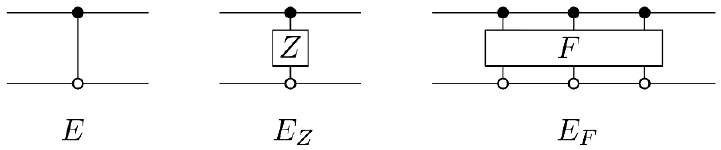
Figure 2 . The transfer operator E , as well as E Z for Z 2 B ( C p ), and E F for F 2 ( C p ) (cid:10) 3 .